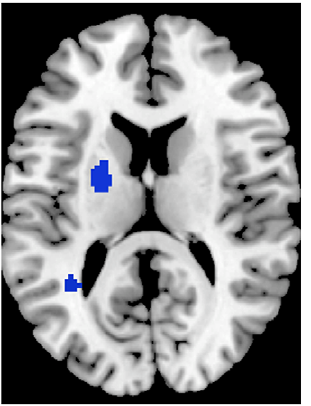
Figure 2. Greater grey matter volumes in ASD and Schizo- phrenia. Clusters indicating relationship between brain regions and condition are colour-coded as follows: blue for clusters contributed to mostly by schizophrenia studies, yellow for clusters contributed to mostly by ASD studies, and green for clusters contributed to by both conditions.